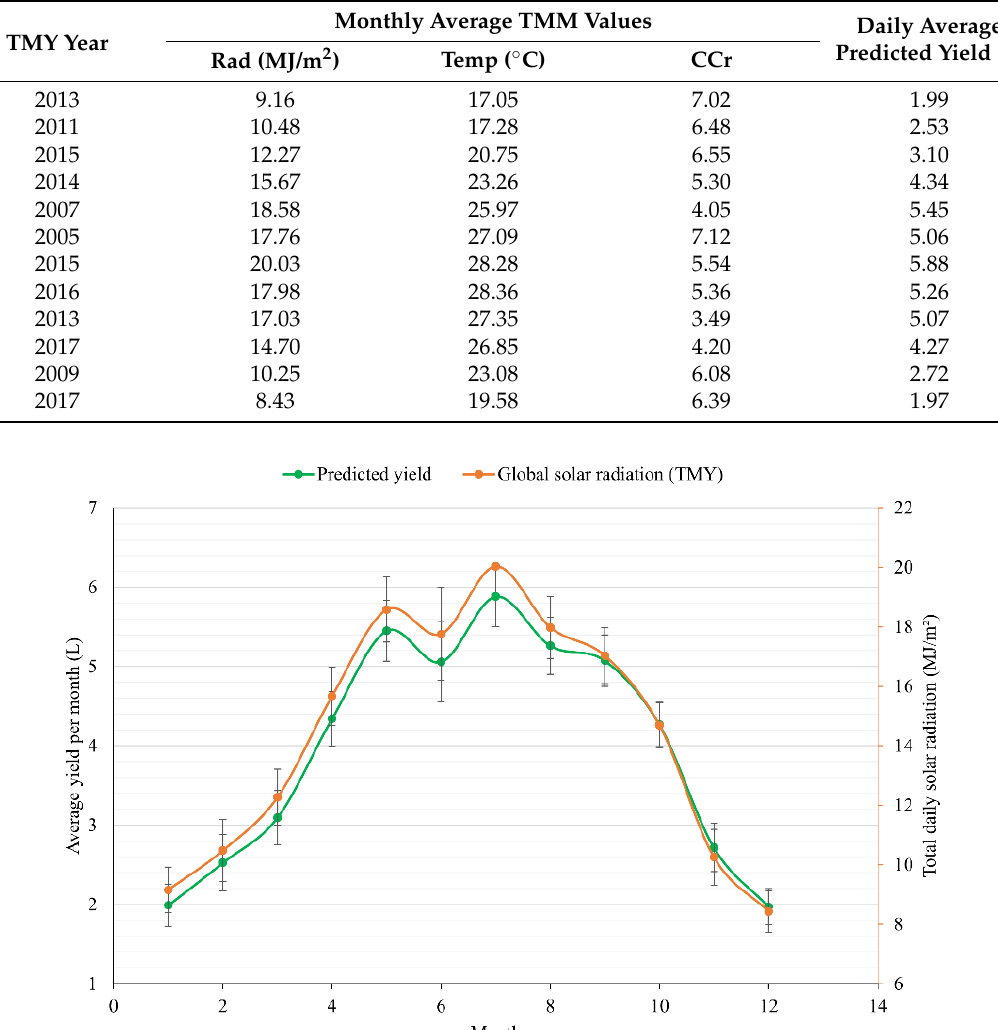
Figure 8. Variation in the monthly average predicted yield and TMY global solar radiation for Dongji